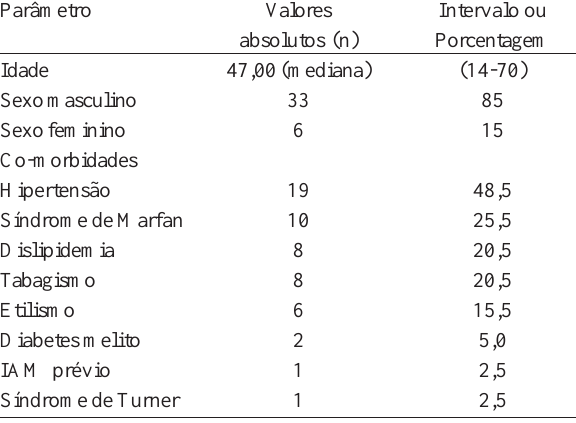
Tabela 1. Dados pré-operatórios e co-morbidades (n = 39)